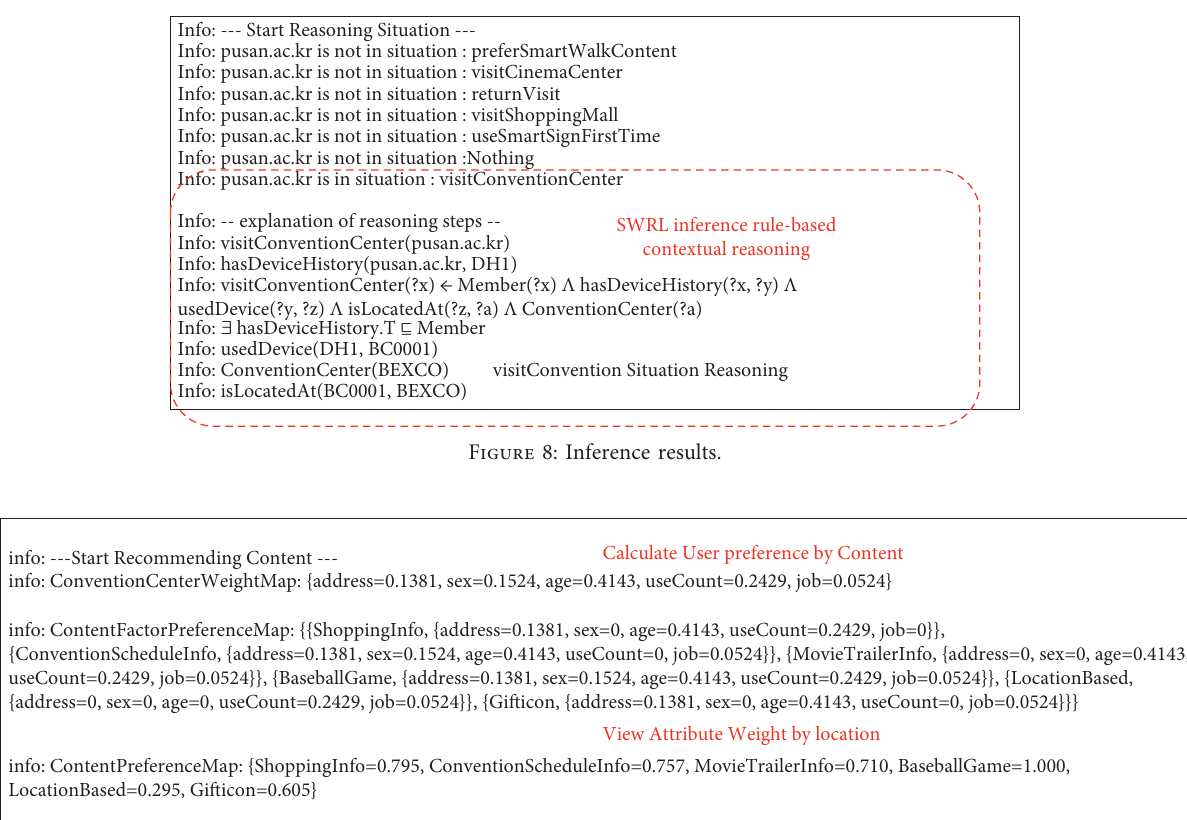
Figure 9: Calculation of user